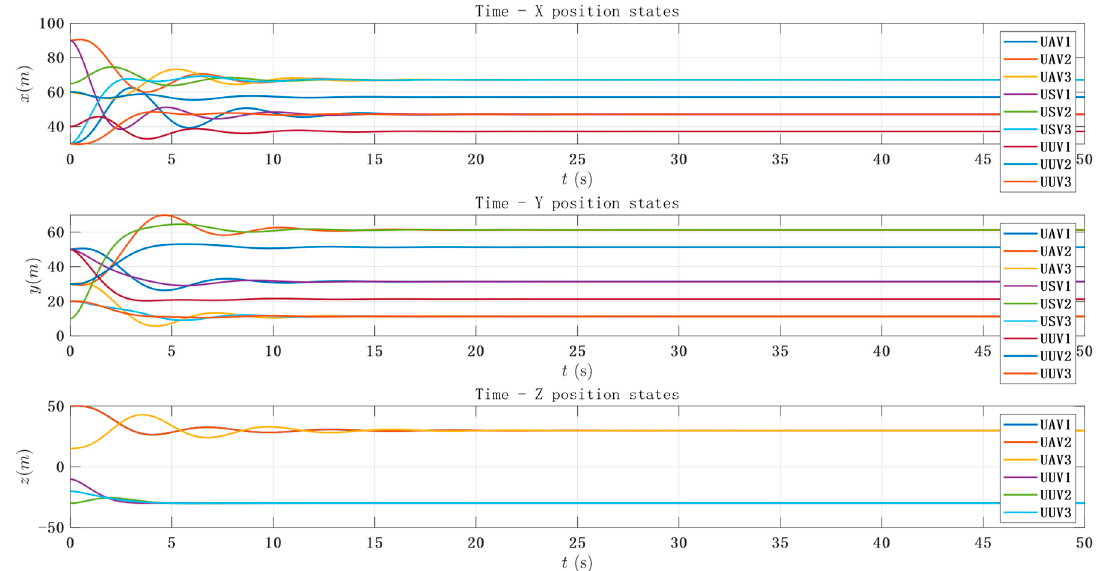
Figure 10. Position state with static cooperative optimum formation control.